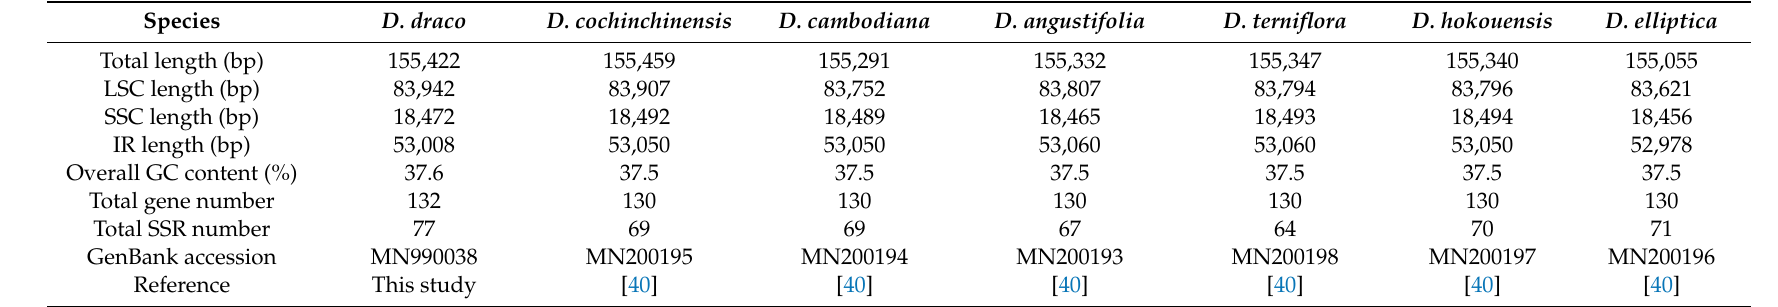
Table 3. Basic features of seven Dracaena chloroplast